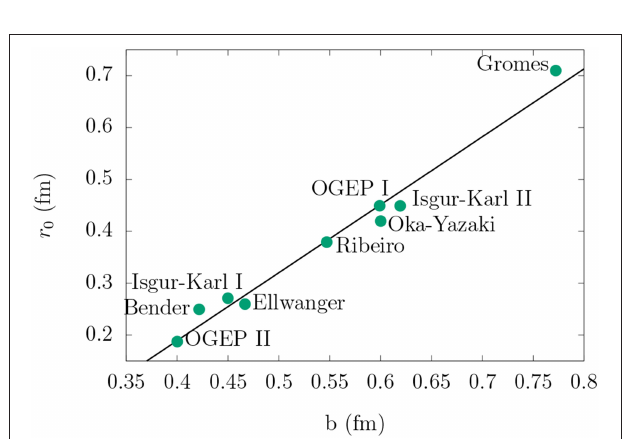
FIGURE 2 | Hard-core radius r 0 as a function of the oscillator length b for different quark-quark forces. The potentials are from ref OGEP I and OGEP II [17], Bender [42], Isgur-Karl I [43], Isgur-Karl II [44] Ellwanger [45], Ribeiro [ 13], Oka-Yazaki [12], and Gromes